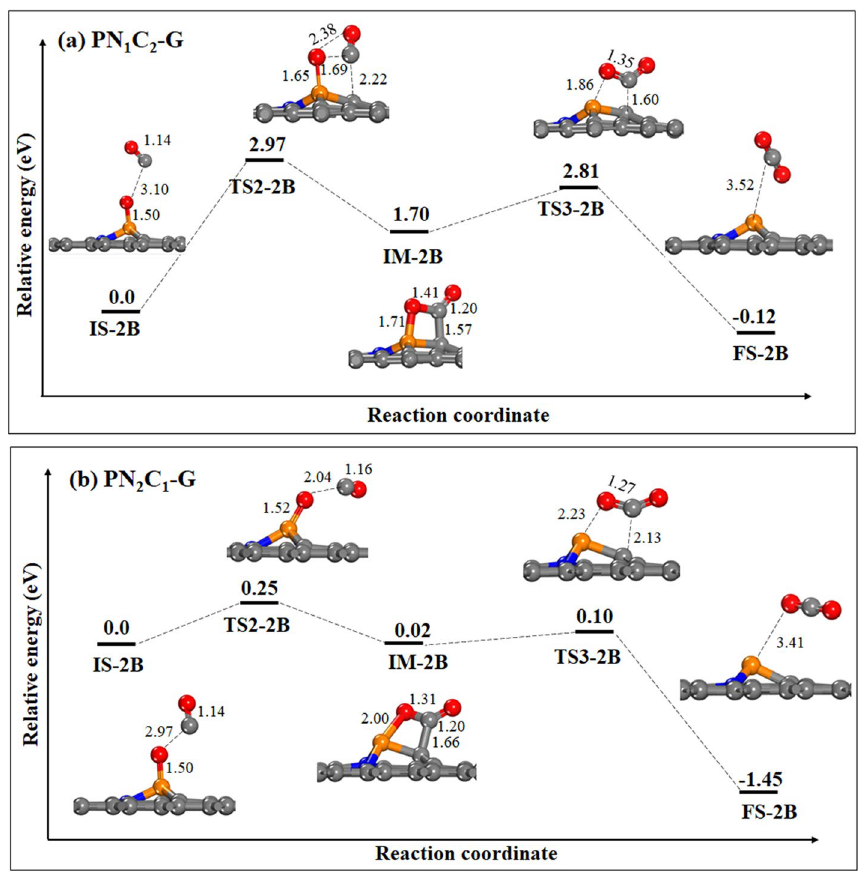
Figure 6. The potential energy surface diagram of CO oxidation via the second step in pathway B. ( a ) PN 1 C 2 -G and ( b ) PN 2 C 1 -G . All bond distances are in